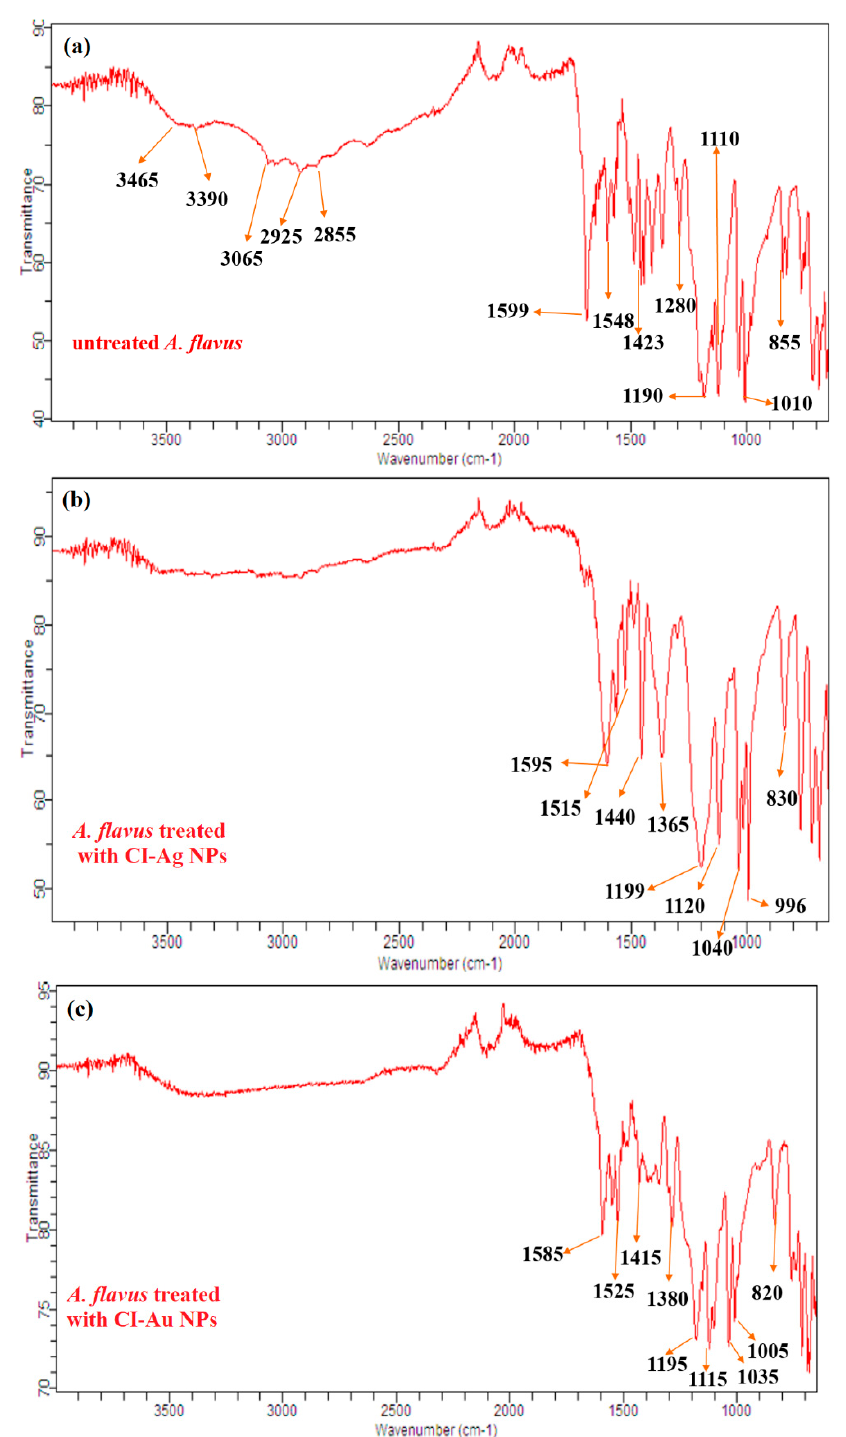
Figure 12. FTIR of ( a ) untreated and treated A. flavus with ( b ) CI-Ag NPs and ( c ) CI-Au NPs synthesized by using C. inerme leaves extract.